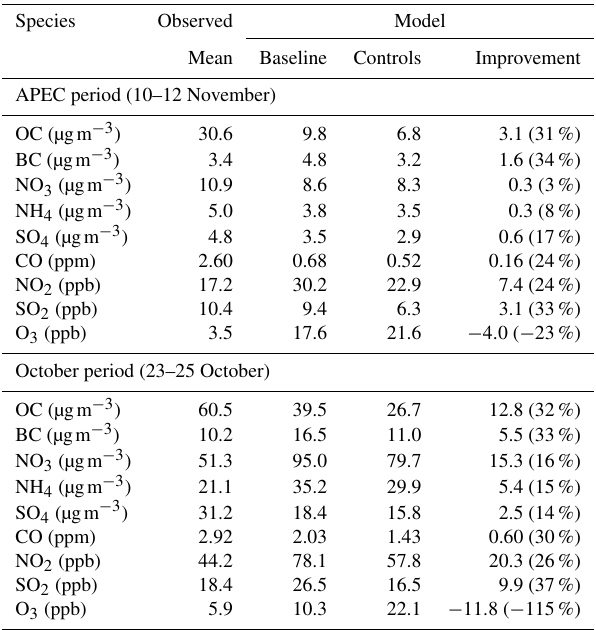
Code and data availability. The WRF-Chem code is avail- Table 8. Influence of emission controls at IAP site in October and November. able from (Skamarock et al., 2008). The name list for the model Species Observed Model and surface pollutant distributions generated in this study are available from the Lancaster University data archive at Mean Baseline Controls Improvement https://doi.org/10.17635/lancaster/researchdata/300 (Ansari,